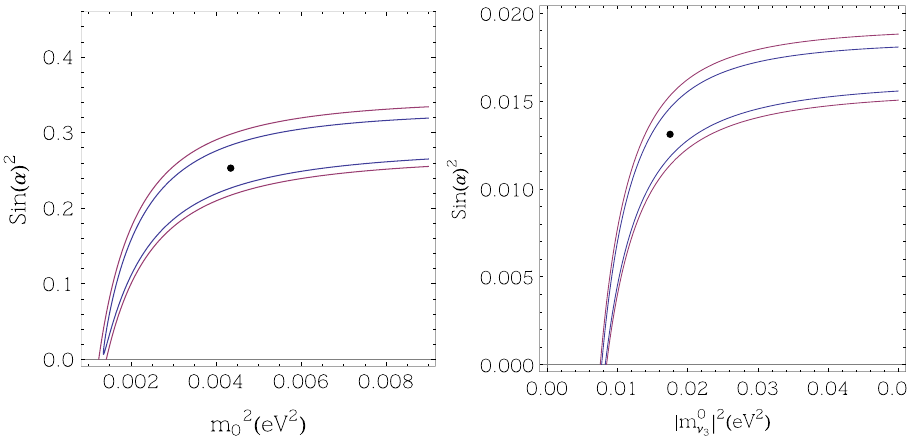
Fig. 3 Allowed regions in the sin (α) – (cid:20) plane, at 90%CL (blue) and 95% CL (red) for degenerate (left) and inverted (right) hierarchy. The θ ν parameter is fixed to the solar angle and (cid:20) is marginalized